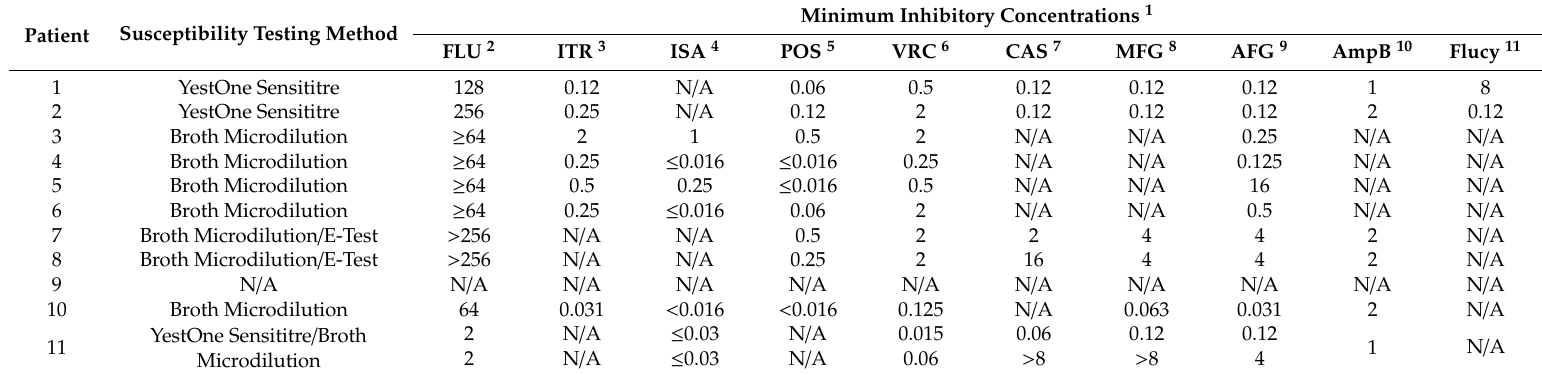
Table 2. Antifungal susceptibility data of C. auris isolates from patient cases in Table